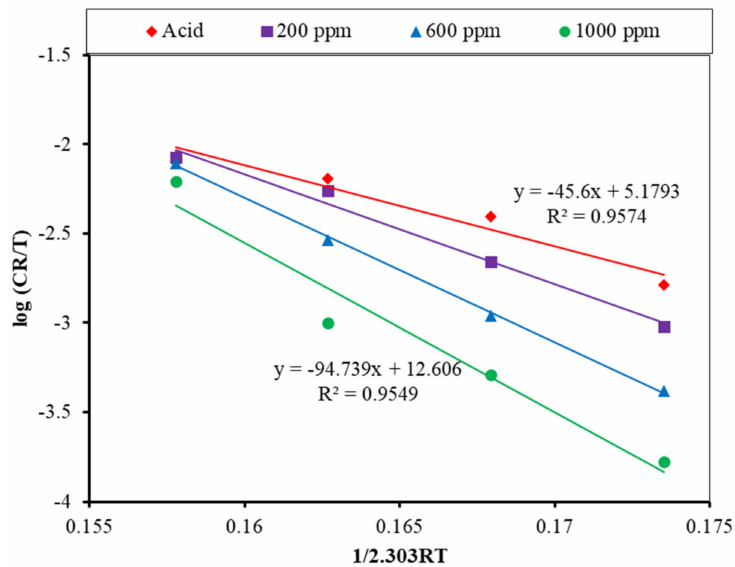
Figure 13. Transition state plot for the MS in the 1 M H 2 SO 4 , both with and without an inhibitor.